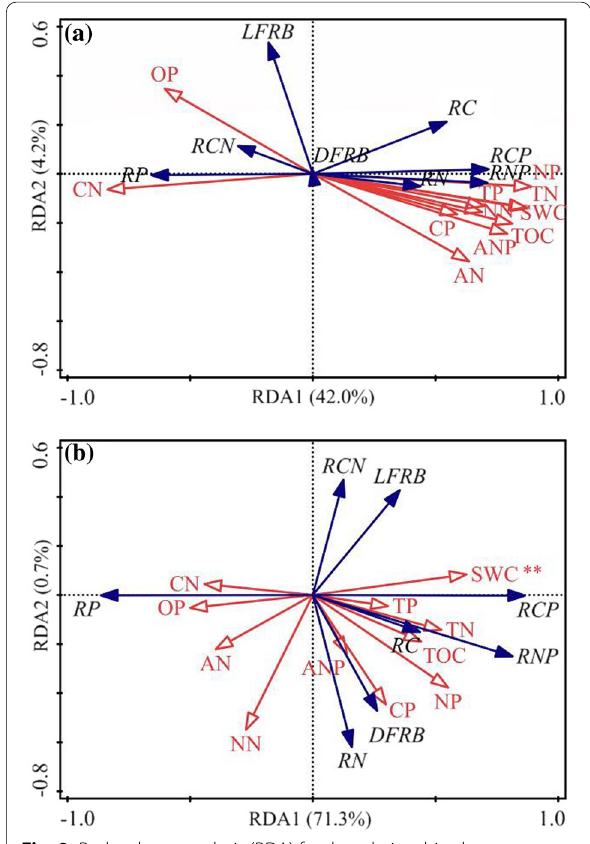
Fig. 8 Redundancy analysis (RDA) for the relationships between fine‑root nutrients [fine‑root C (RC), N (RN), P (RP), C:N ratio (RCN), C:P ratio (RCP), N:P ratio (RNP)] and biomass [dead fine‑root biomass (DFRB) and live fine‑root biomass (LFRB)] and soil properties [soil water content (SWC), NH 4 + ‑N (AN), NO 3 − ‑N (NN), Olsen‑P (OP), available N:P ratio (ANP), total organic C (TOC), total N (TN), total P (TP), C:N ratio (CN), C:P ratio (CP), N:P ratio (NP)] in 0–20 cm and 20–40 cm soil layers. ** P <